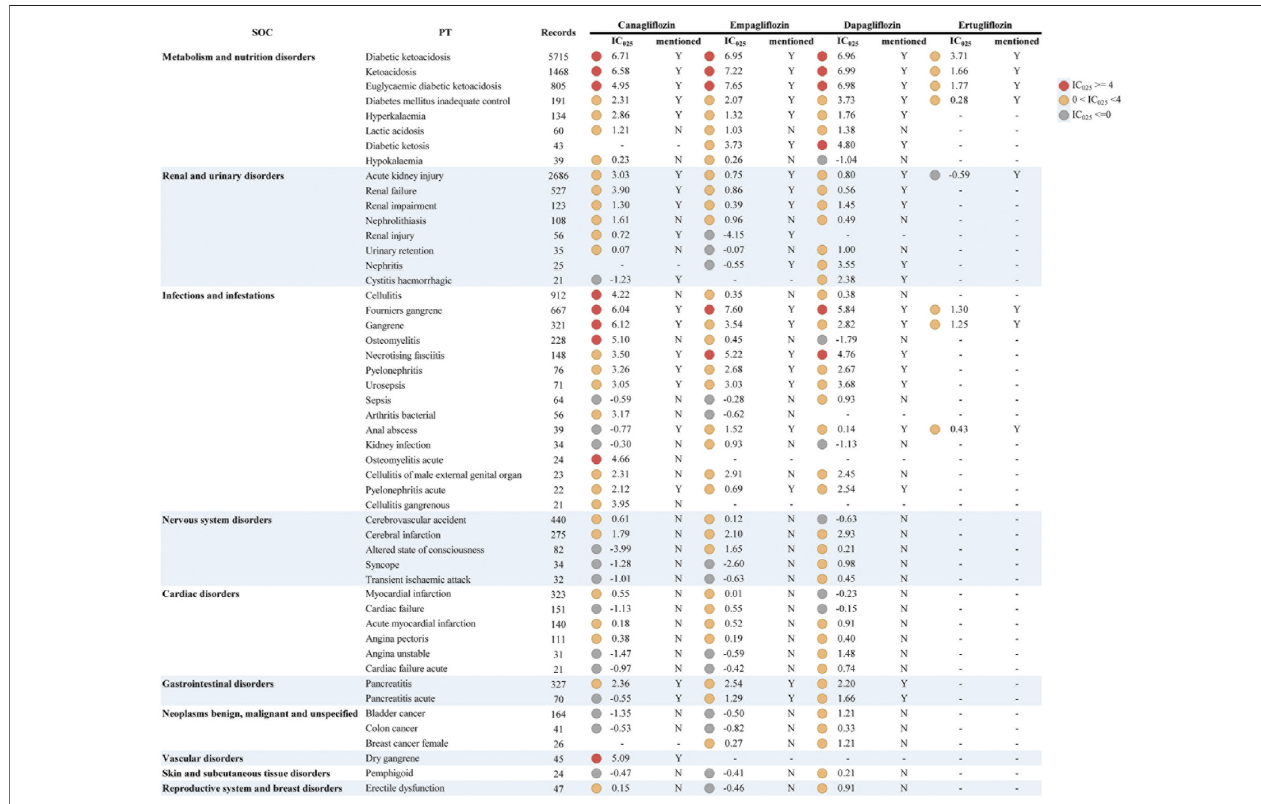
FIGURE1| Signalpro fi lesoftop50IMEsinducedbySGLT2imonotherapy-based onallotherdrugsas “ non-case ” **In Figure1 ,IMEs,ImportantMedicalEvents; SOC,SystemOrganClass;PT,PreferredTerm;IC,informationcomponent;IC 025 ,thelowerlimitofthe95%con fi denceintervalofIC.IC 025 greaterthan0wasdeemeda signal. IC 025 no less than 4 was deemed a strong